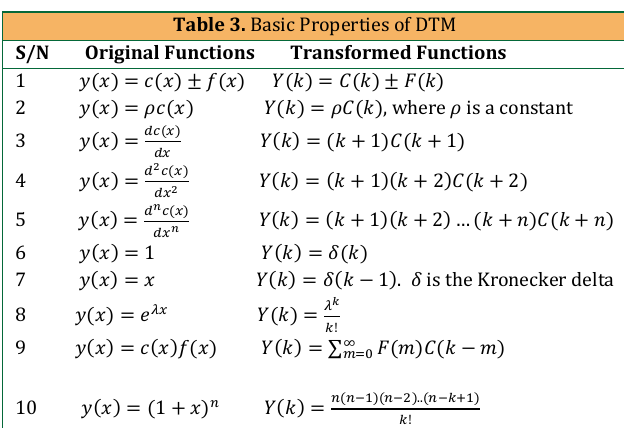
Table 3. Basic Properties of DTM